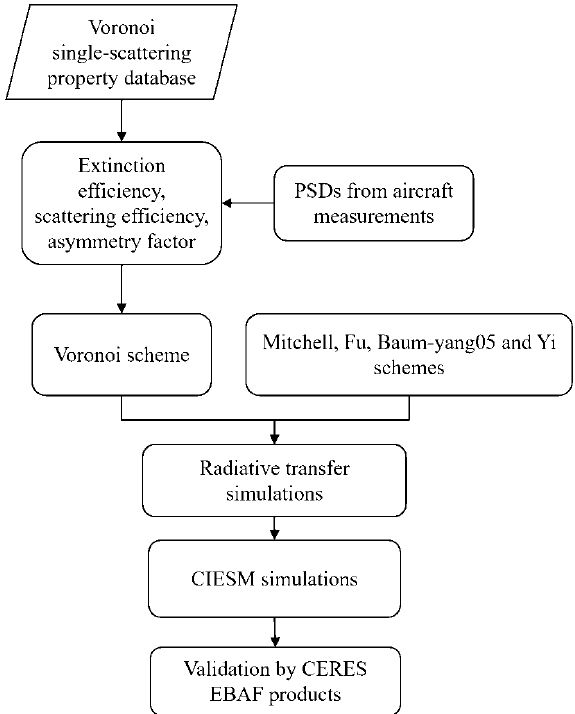
Figure 3. Flowchart of the investigation of ice cloud modeling ca- pabilities for the irregularly shaped Voronoi models in climate sim-